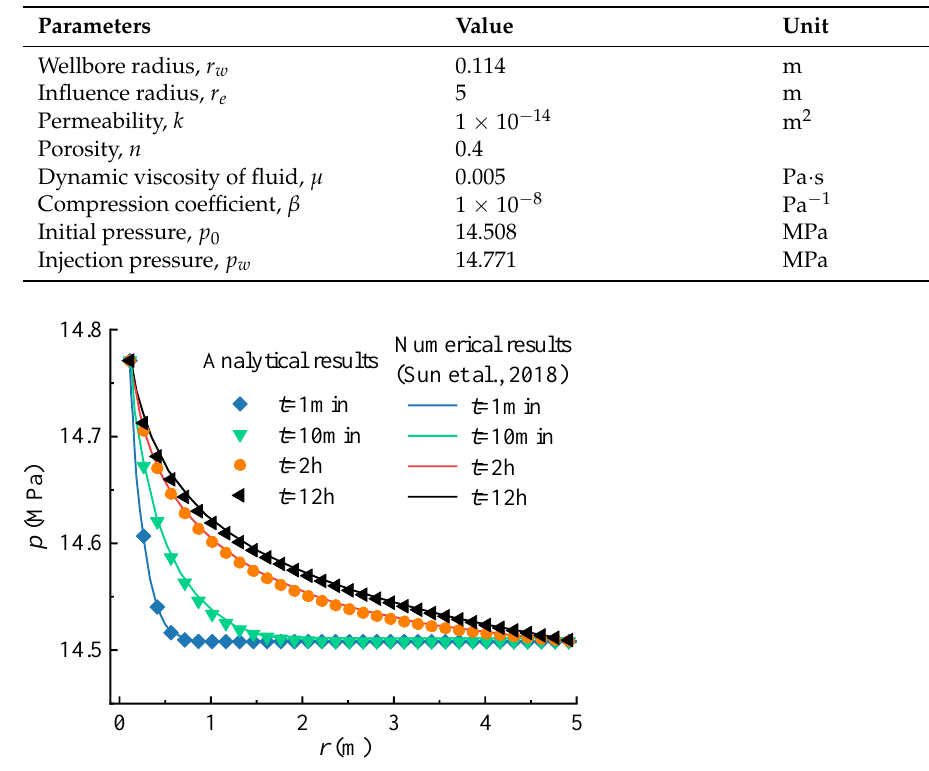
12 of 24 Figure 3. Pore pressure contours of the numerical calculation (FLAC3D).